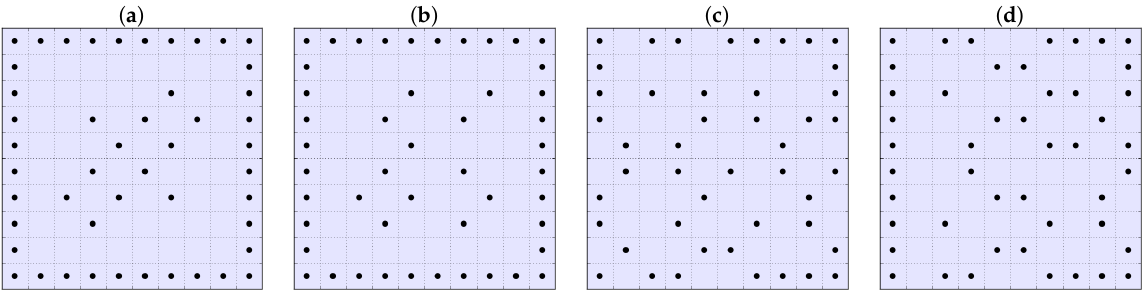
Figure 14. Reported optimal wind farm layouts for case 3. ( a ) Present (SO). ( b ) Present (MO). ( c ) Huang et al. [8] (SGA). ( d ) Huang et al. [8]